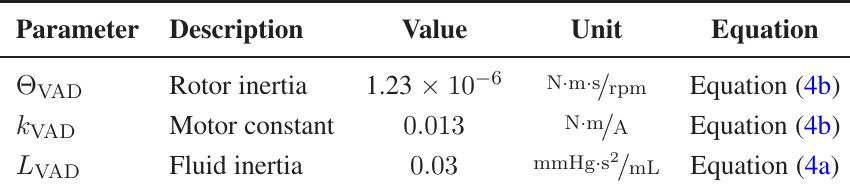
Table A3. Parameters of the pump